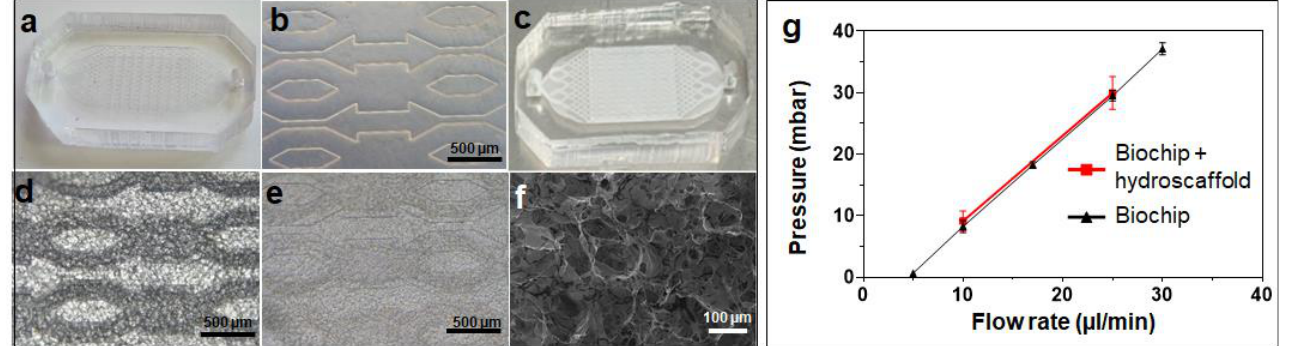
Figure 2. Microfluidic devices and hydroscaffold characterization. ( a ) microfluidic biochip; ( b ) mi- croscopic observation of biochip microstructures; ( c ) biochip containing the hydroscaffold; ( d ) mi- croscopic observation of dehydrated hydroscaffold inside biochip; ( e ) microscopic observation of hydrated hydroscaffold inside biochip; ( f ) SEM observation of the hydroscaffold; and ( g ) character- ization of the pressure variation in the biochip with and without hydroscaffold.